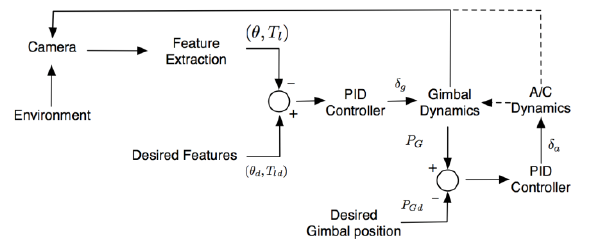
Figure 5. High level control architecture for the active guidance. Sub-index 𝒅 denotes desired values and 𝜹 are the commanded